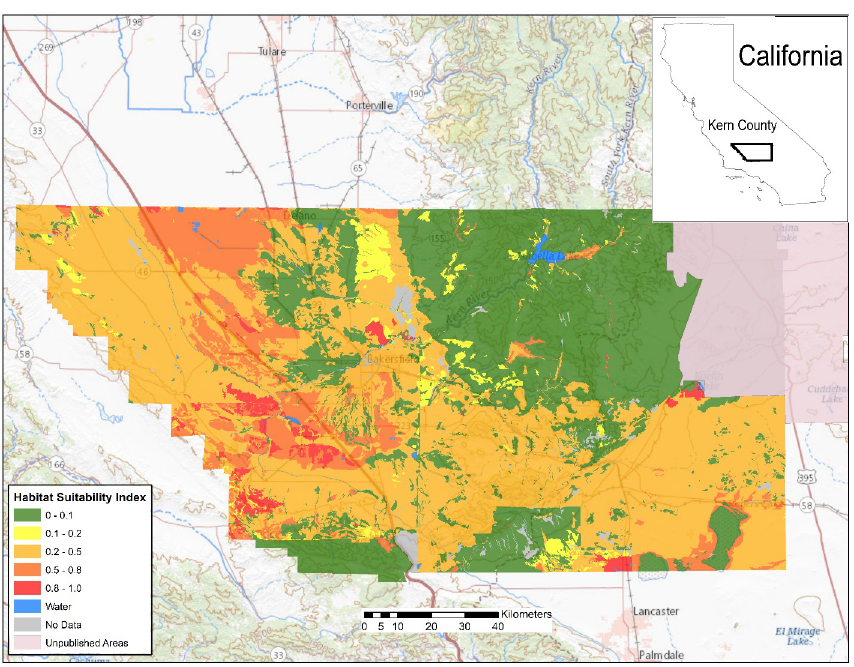
Fig 4. Predicted Coccidioides habitat suitability index for Kern County, California, which has the highest incidence of coccidioidomycosis in the state.